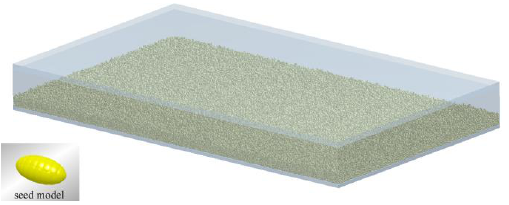
Figure 2. Snapshot of DEM simulation.